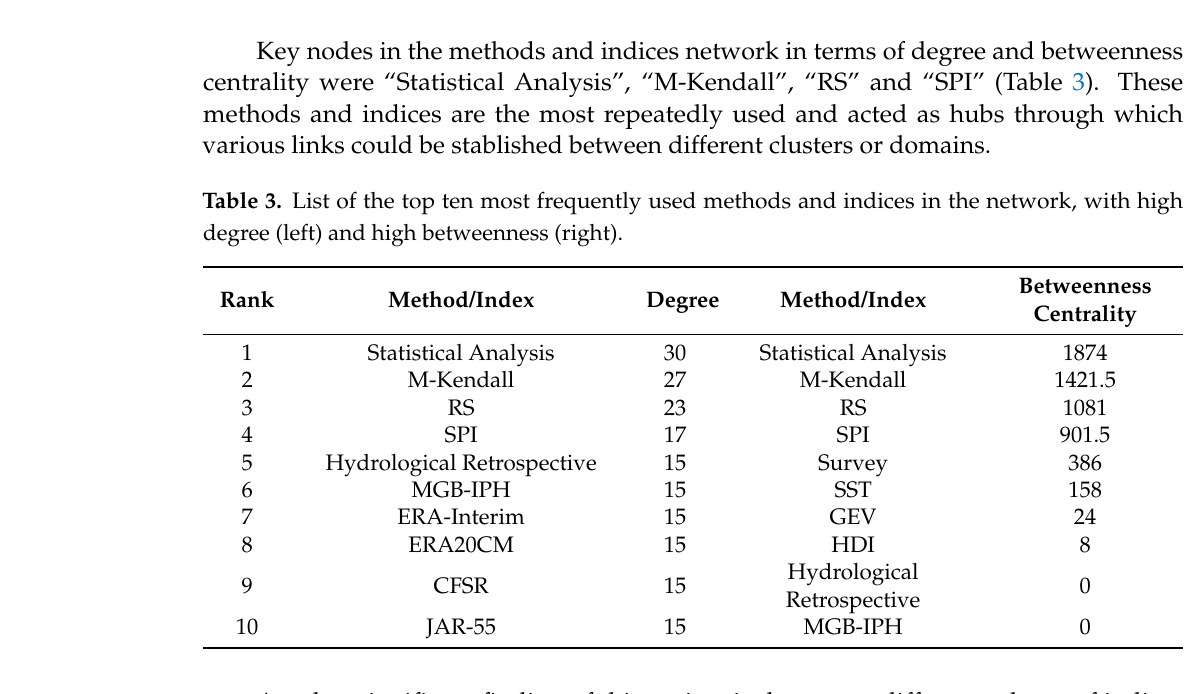
Table 2. Overall metrics for the methods and indices network. Average Geodesic Distance Average Clustering Coefficient Graph Density Average Degree 2.66 0.935 0.06 7.19 Key nodes in the methods and indices network in terms of degree and betweenness centrality were “Statistical Analysis”, “M-Kendall”, “RS” and “SPI” (Table 3). These